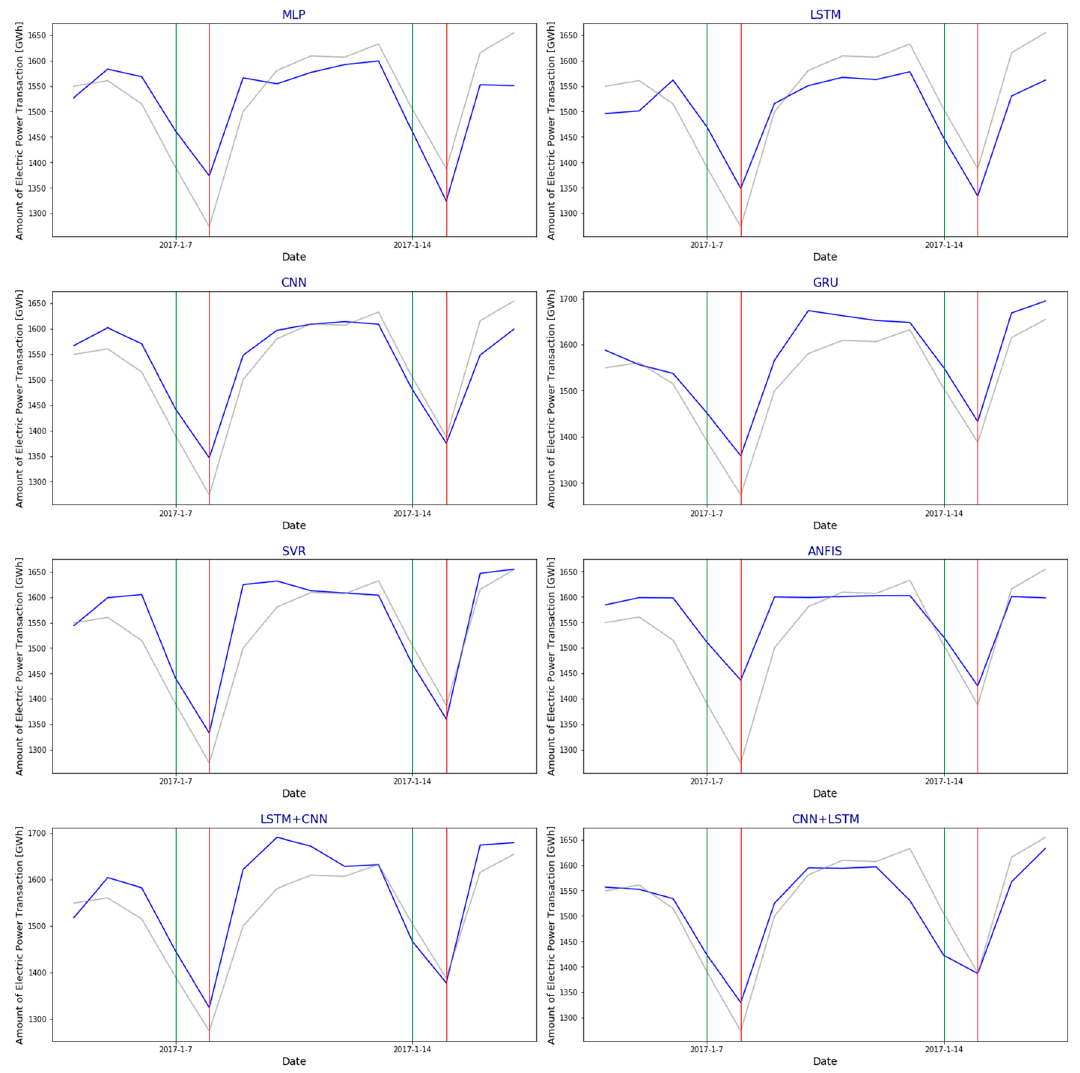
Figure 29. Comparison of week patterns with different algorithms.